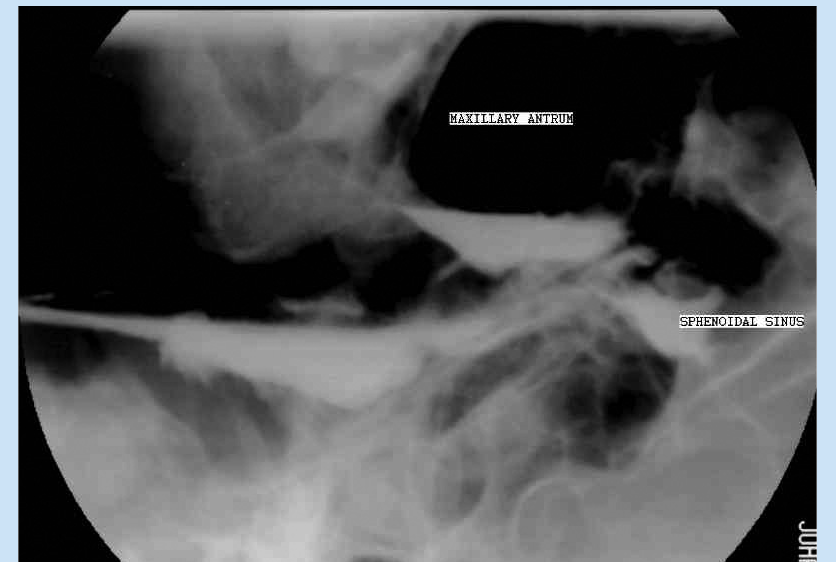
Fig. 1. Contrast in the sphenoidal sinus and maxillary